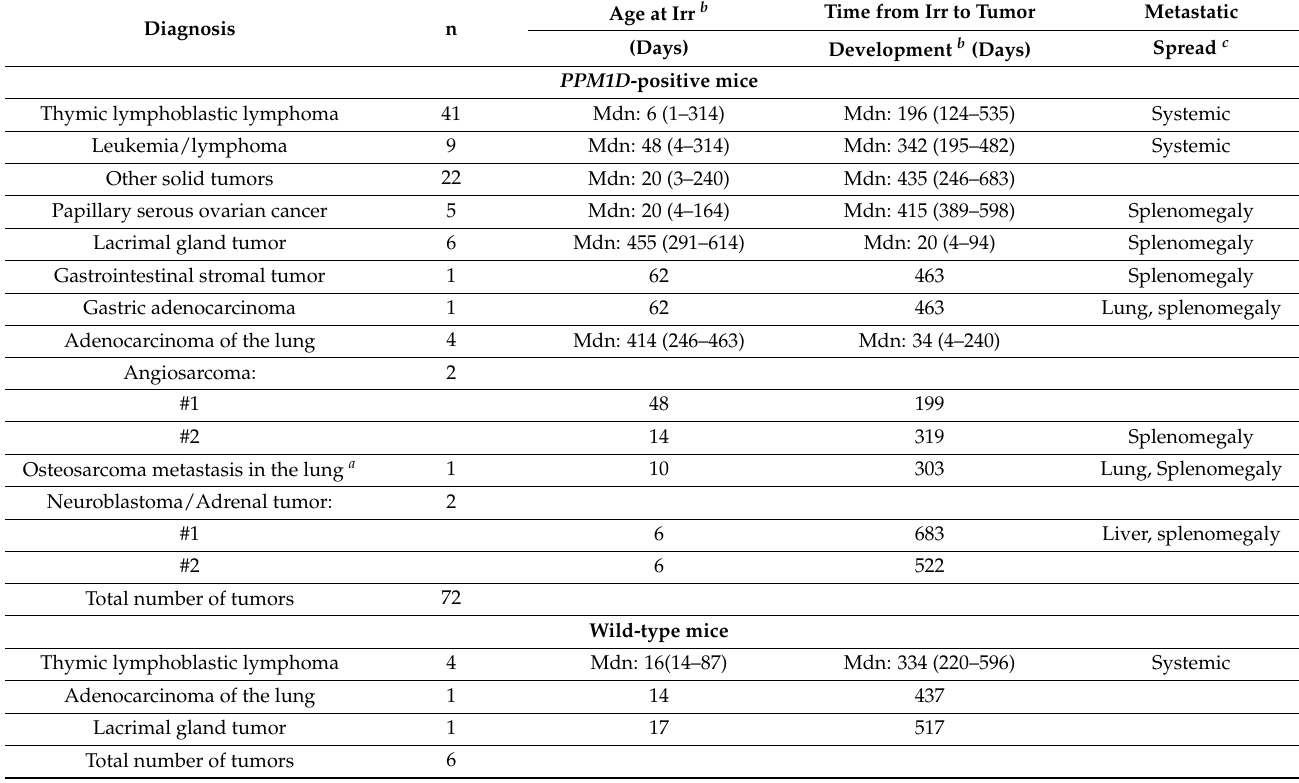
Table 1. List of tumors developed in irradiated PPM1D -transgenic mice, related to Figure 2. Age at Irr b Time from Irr to Tumor Metastatic Diagnosis n (Days) Development b (Days) Spread c PPM1D -positive